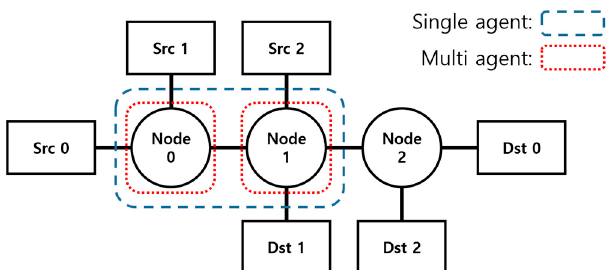
Figure 1. Node architecture used in the simulation.